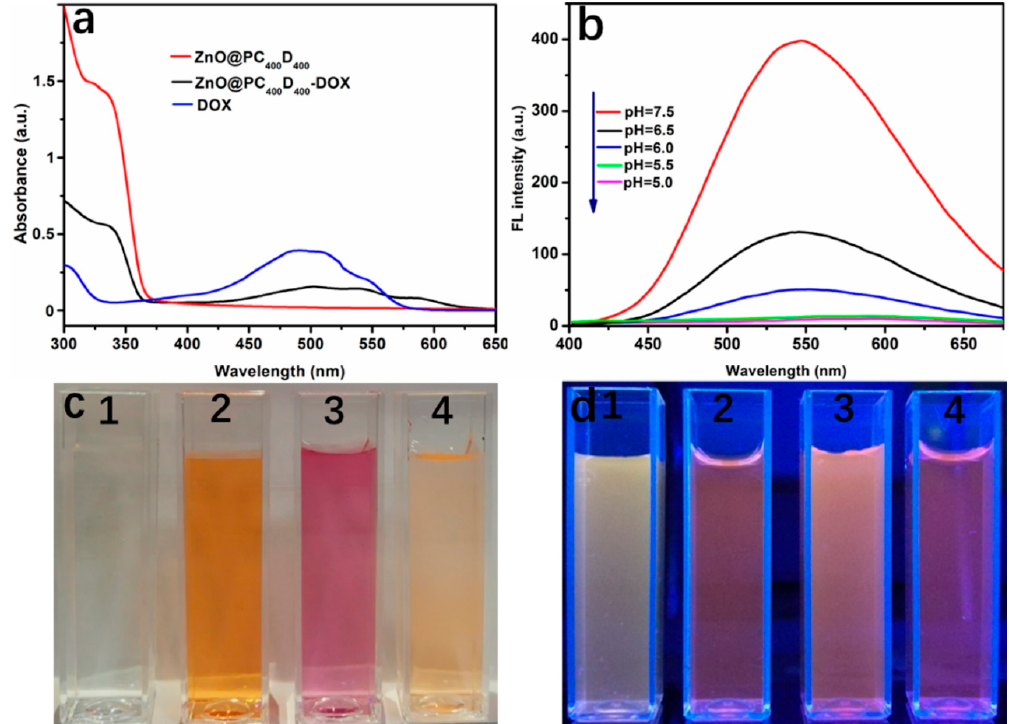
Figure 5. ( a ) UV − vis absorbance spectra of ZnO@PC 400 D 400 , ZnO@PC 400 D 400 -DOX, and free DOX; ( b ) fluorescence spectra of ZnO@PC 400 D 400 incubated at different pH under an excitation of 330